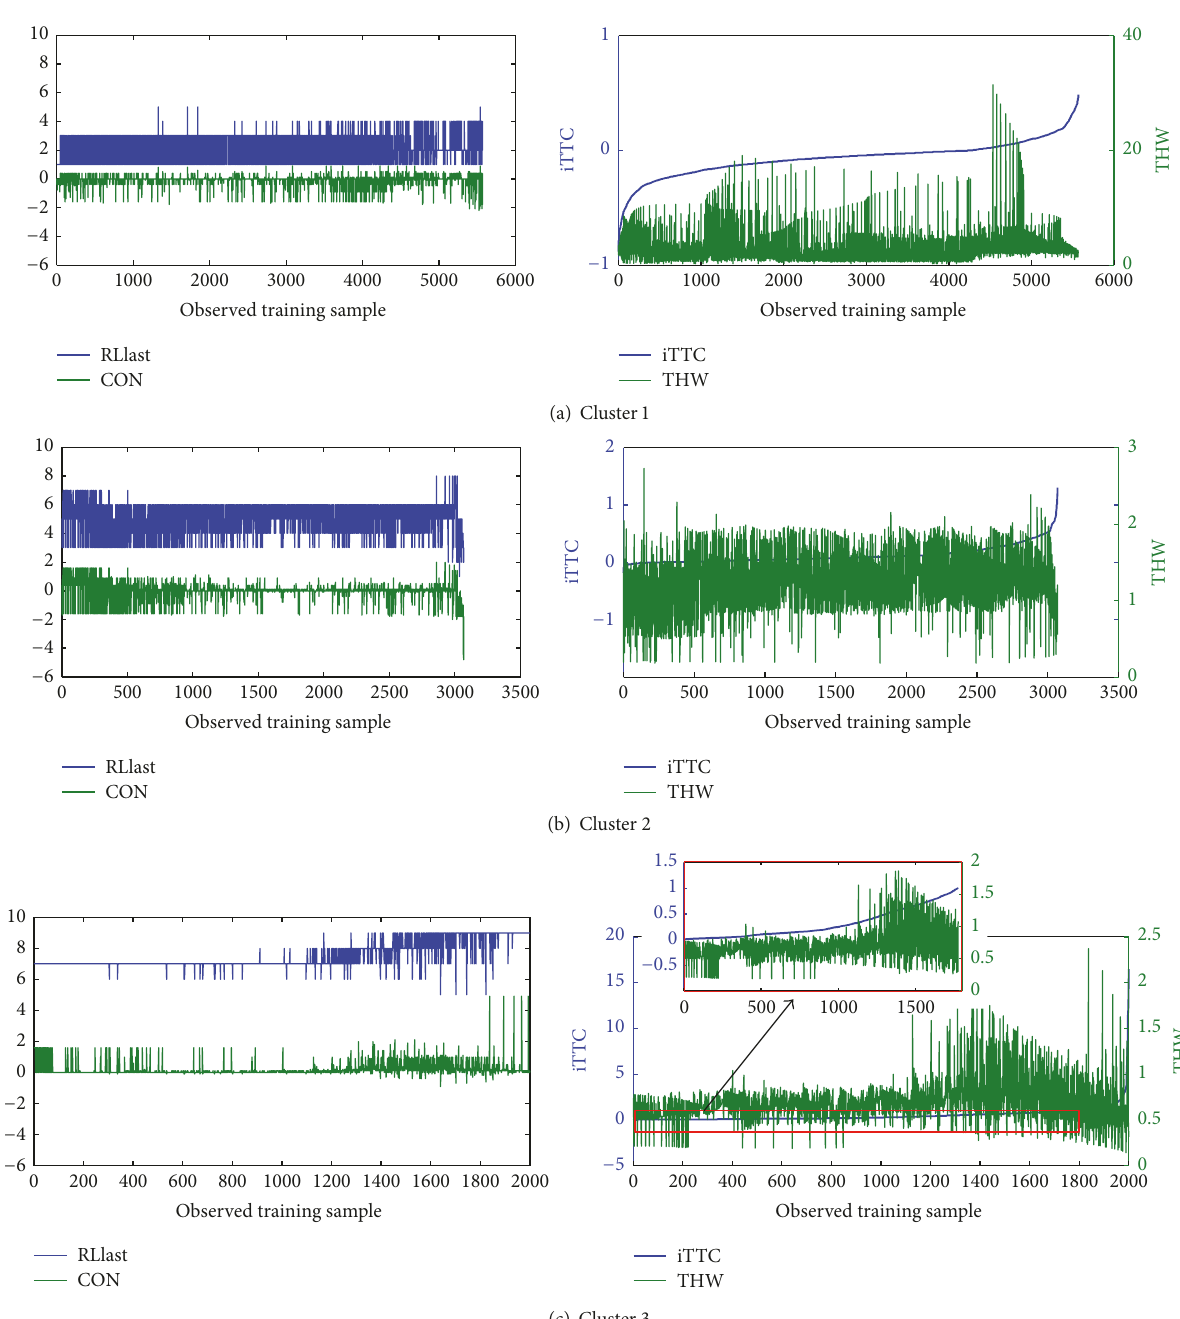
Figure 11: Driving risk level time window clustering results. Note . The random observed time window samples were sorted according to the average value of iTTC within the time window for easier understanding.